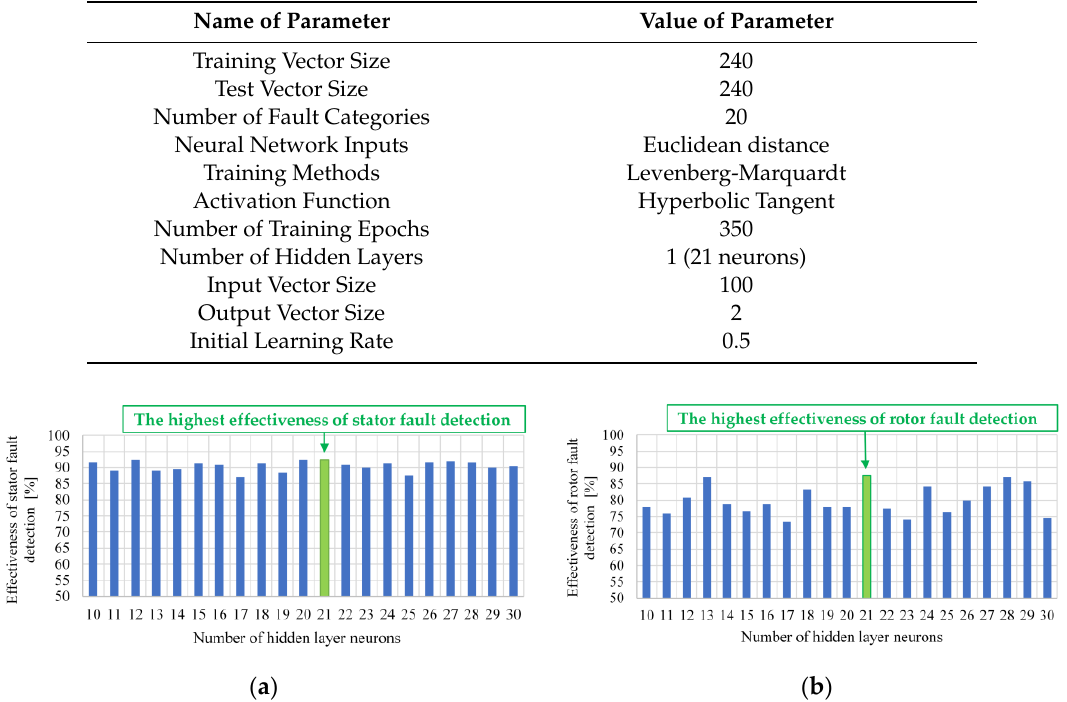
Table 6. Parameters of the MLP network and training process.